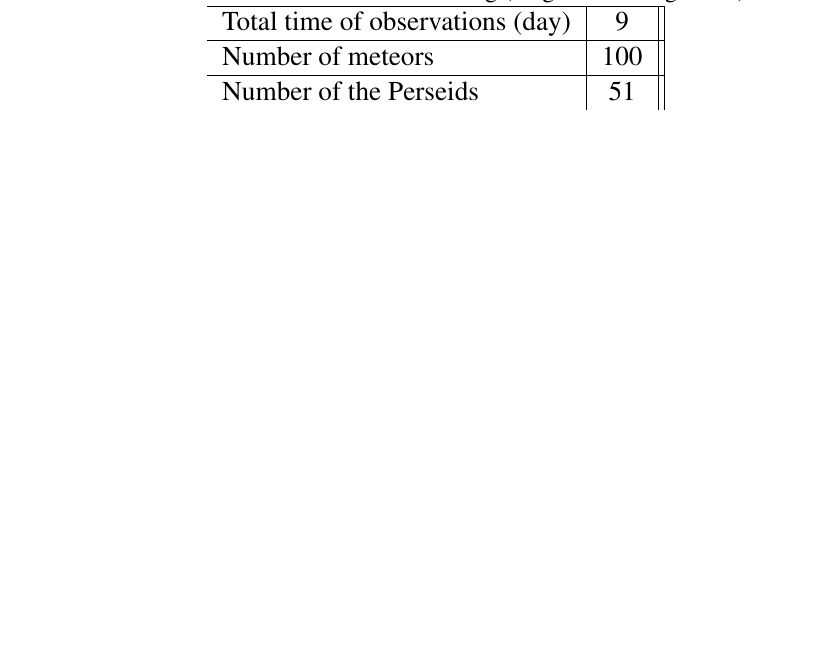
Table 1 results of meteors observation during (August 5 to August 13) in